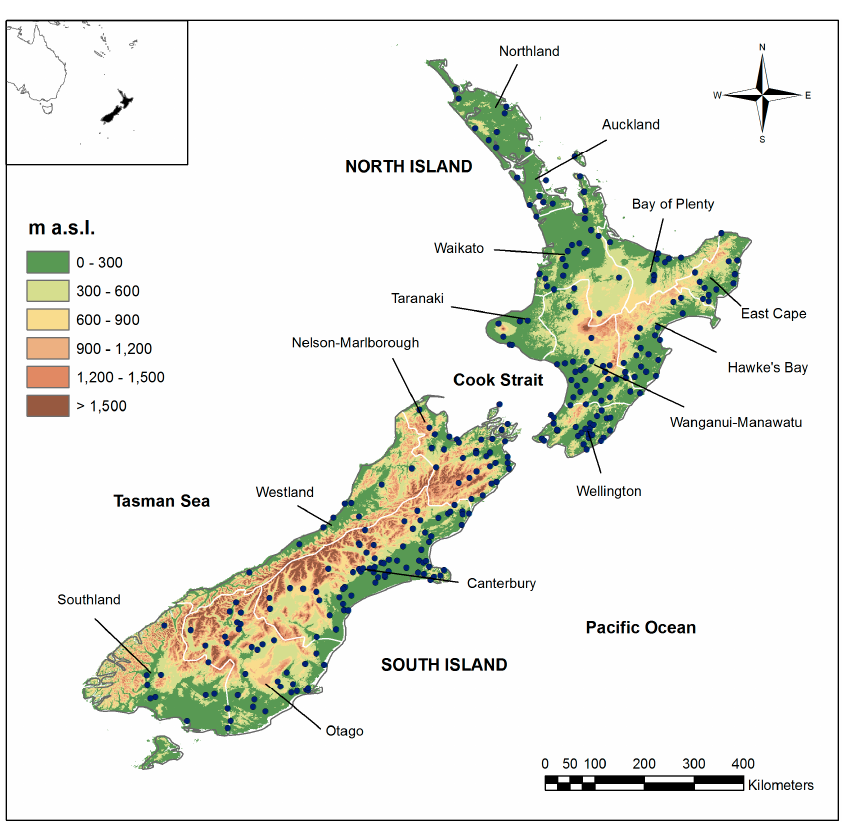
Figure 2. Location of the 14 regions of New Zealand and of the selected 294 rain gauge stations on a Digital Elevation Model (DEM) of New Zealand.